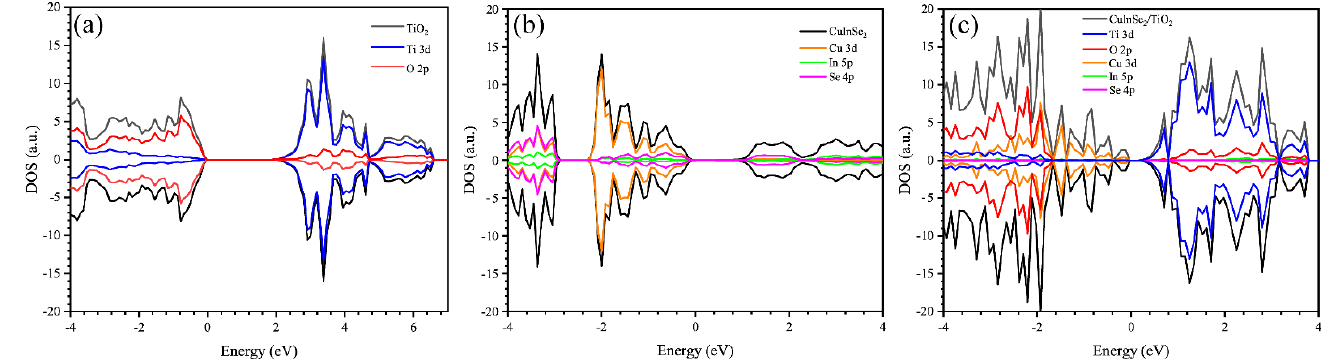
Figure 10. The calculated TDOS and PDOS for ( a ) TiO 2 , ( b ) CuInSe 2 and ( c ) CuInSe 2 /TiO 2 .